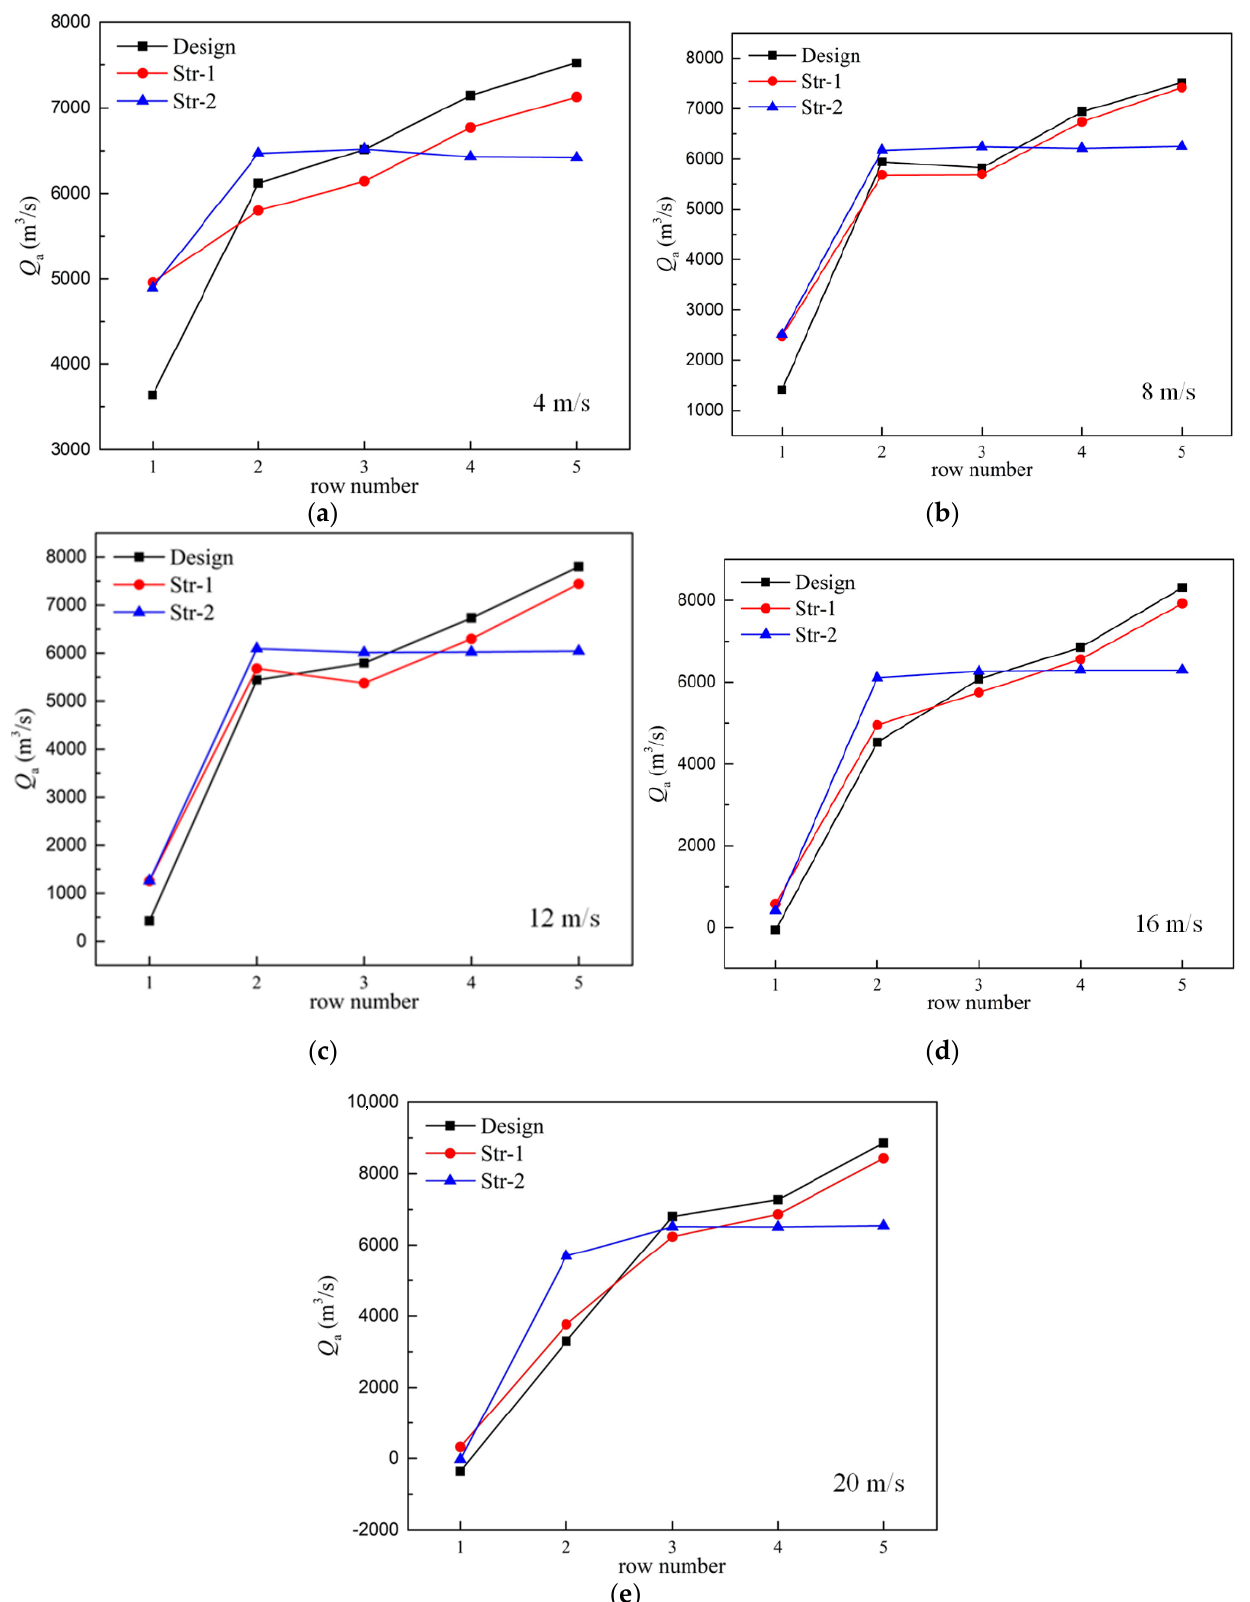
Figure 12. Total volumetric flow rates of fans in each row for Design, Str-1, and Str-2 cases at various wind speeds: ( a ) 4 m/s; ( b ) 8 m/s; ( c ) 12 m/s; ( d ) 16 m/s; ( e ) 20 m/s.